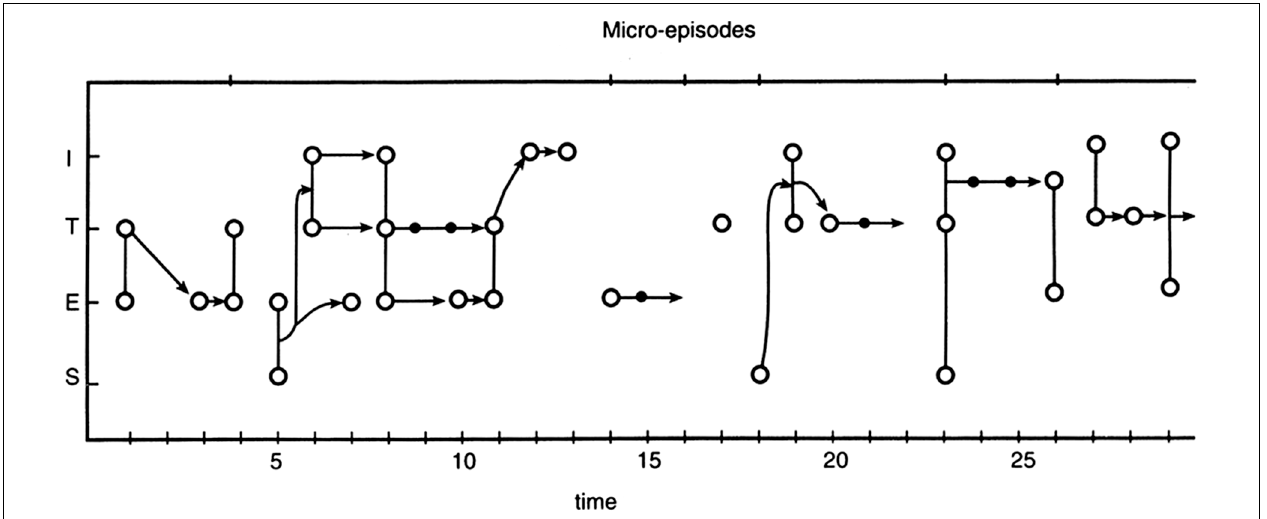
images). Following some rules of Petri nets computational devices (Peterson, 1981) applied in a dynamic process model of consciousness (Díaz, 2007), individual contents detected in each segment are depicted as places ( O ), information processing as arcs ( − ), and mental causality as arrows ( → ). Simultaneous mental tokens detected in a single episode are connected by vertical lines to indicate their binding in a single mental state or